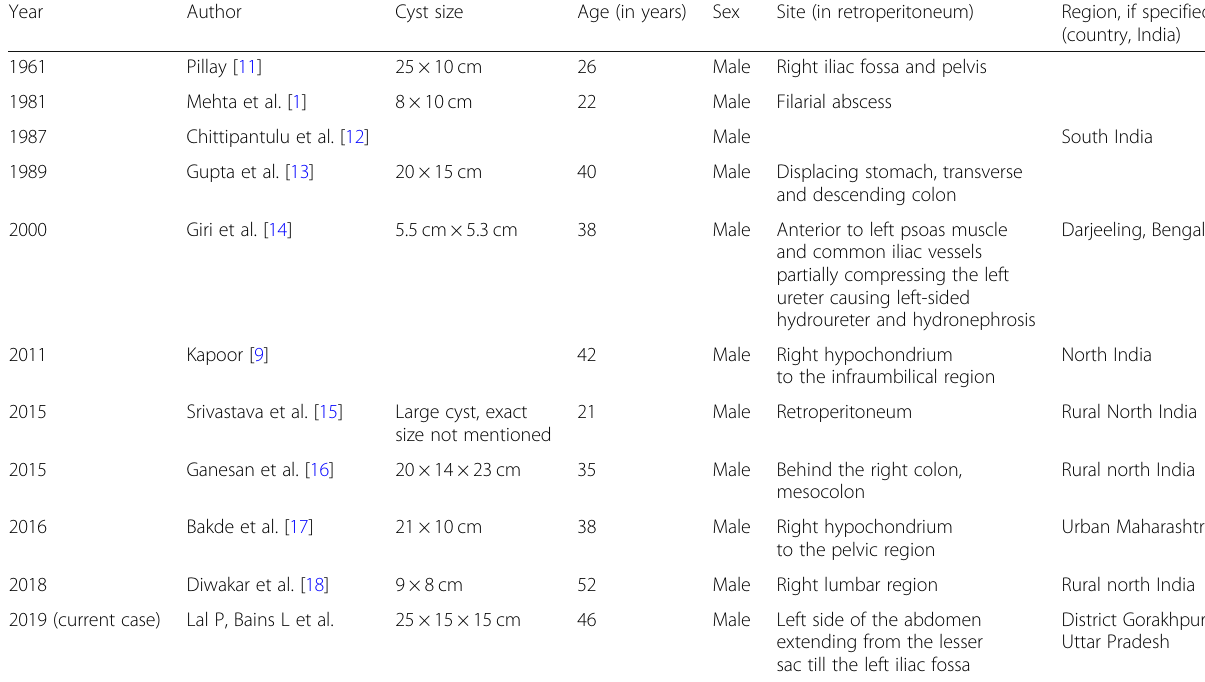
Table 1 Retroperitoneal filarial cyst as mentioned by various